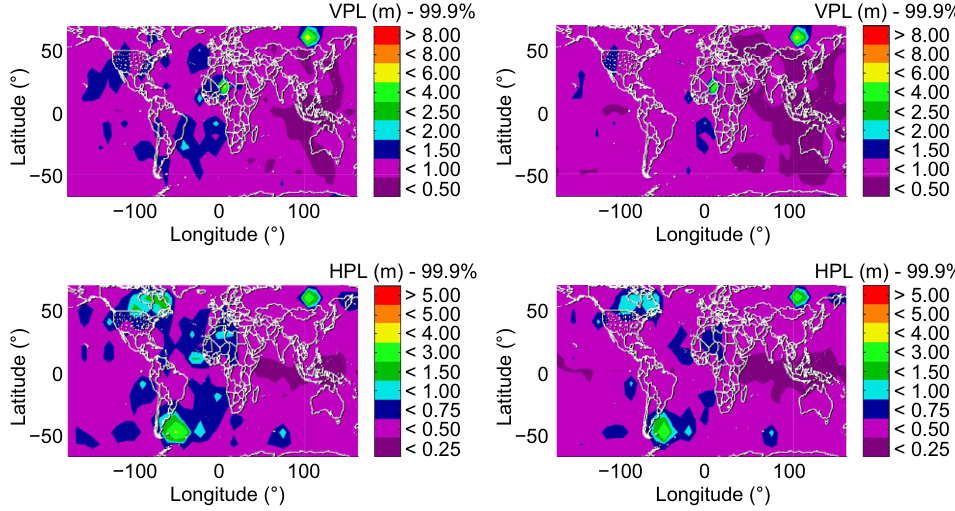
Fig. 5 VPL (top) and HPL (bottom) for PPP-AR (left) and PPP-RTK (right) models as a function of user